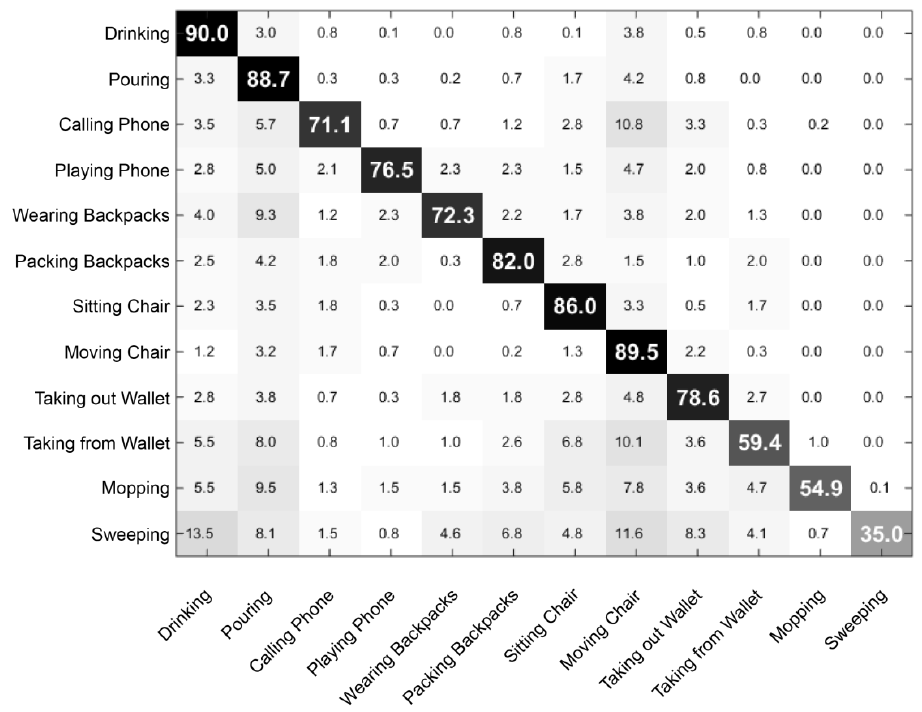
Figure 4. SYSU 3D Human-Object Interaction dataset confusion matrix based on skeleton data 图 4